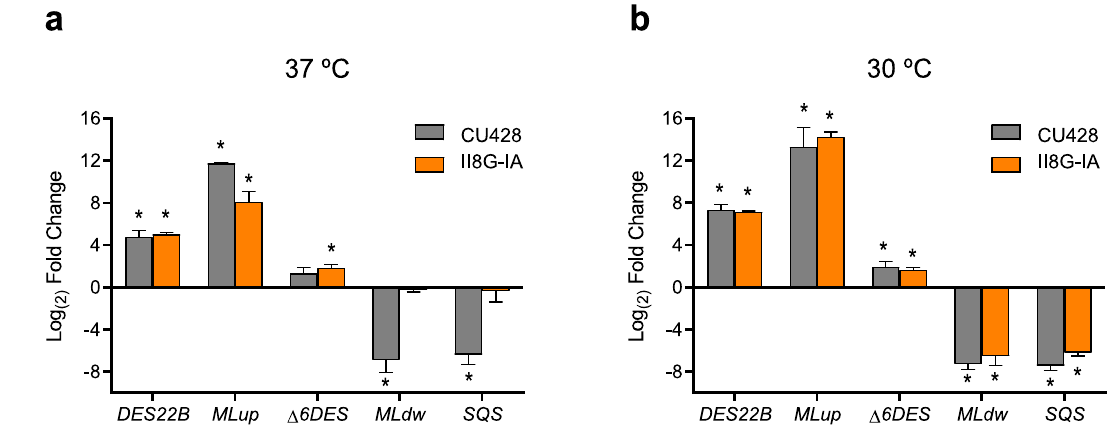
Figure 2. Effect of cholesterol on gene expression depends on the uptake route. Cells of wild-type (CU428) and phagocytosis-deficient (II8G-IA) strains were cultured at 37 °C ( a ) or 30 °C ( b ), and treated with 26 μM cholesterol 1 h prior to RNA extraction. Expression of representative genes involved in sterol and lipid metabolism which are differentially regulated was analyzed by RT-qPCR. Induced genes: DES22B , putative sterol C22 desaturase B; MLup , up-regulated ML domain protein; Δ6DES , delta-6 fatty acid desaturase. Repressed genes: SQS , squalene synthase; MLdw , down-regulated ML domain protein. Data are expressed as mean ± SD (n = 3) log 2 fold change relative to untreated cells of the respective strain. *p < 0.05 vs. untreated cells, Student’s t